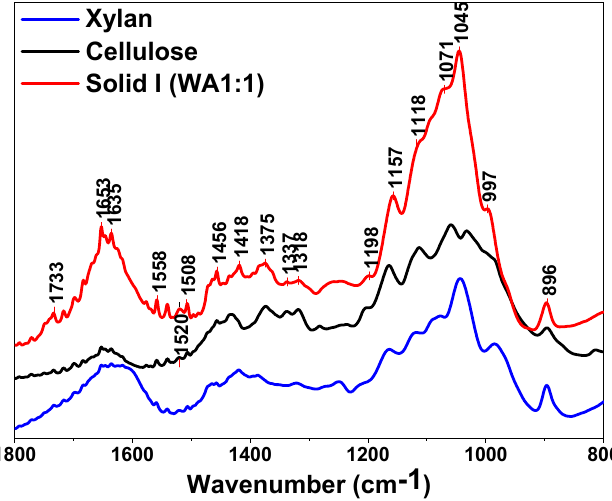
Figure 3. FTIR spectra of Solid I, commercial cellulose and xylan.